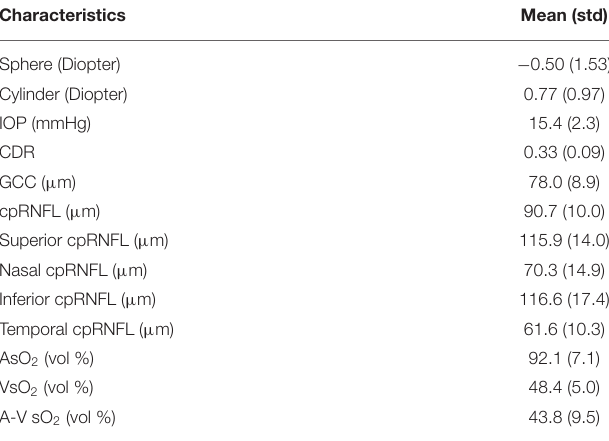
TABLE 2 | Characteristics of ocular measurements from all eyes.